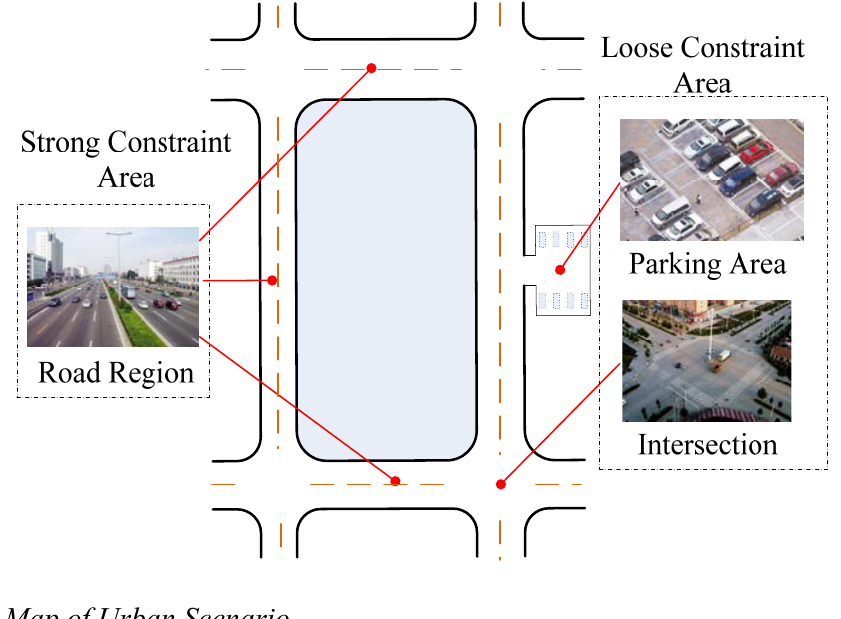
Figure 2. Definitions of strong constraint area and loose constraint